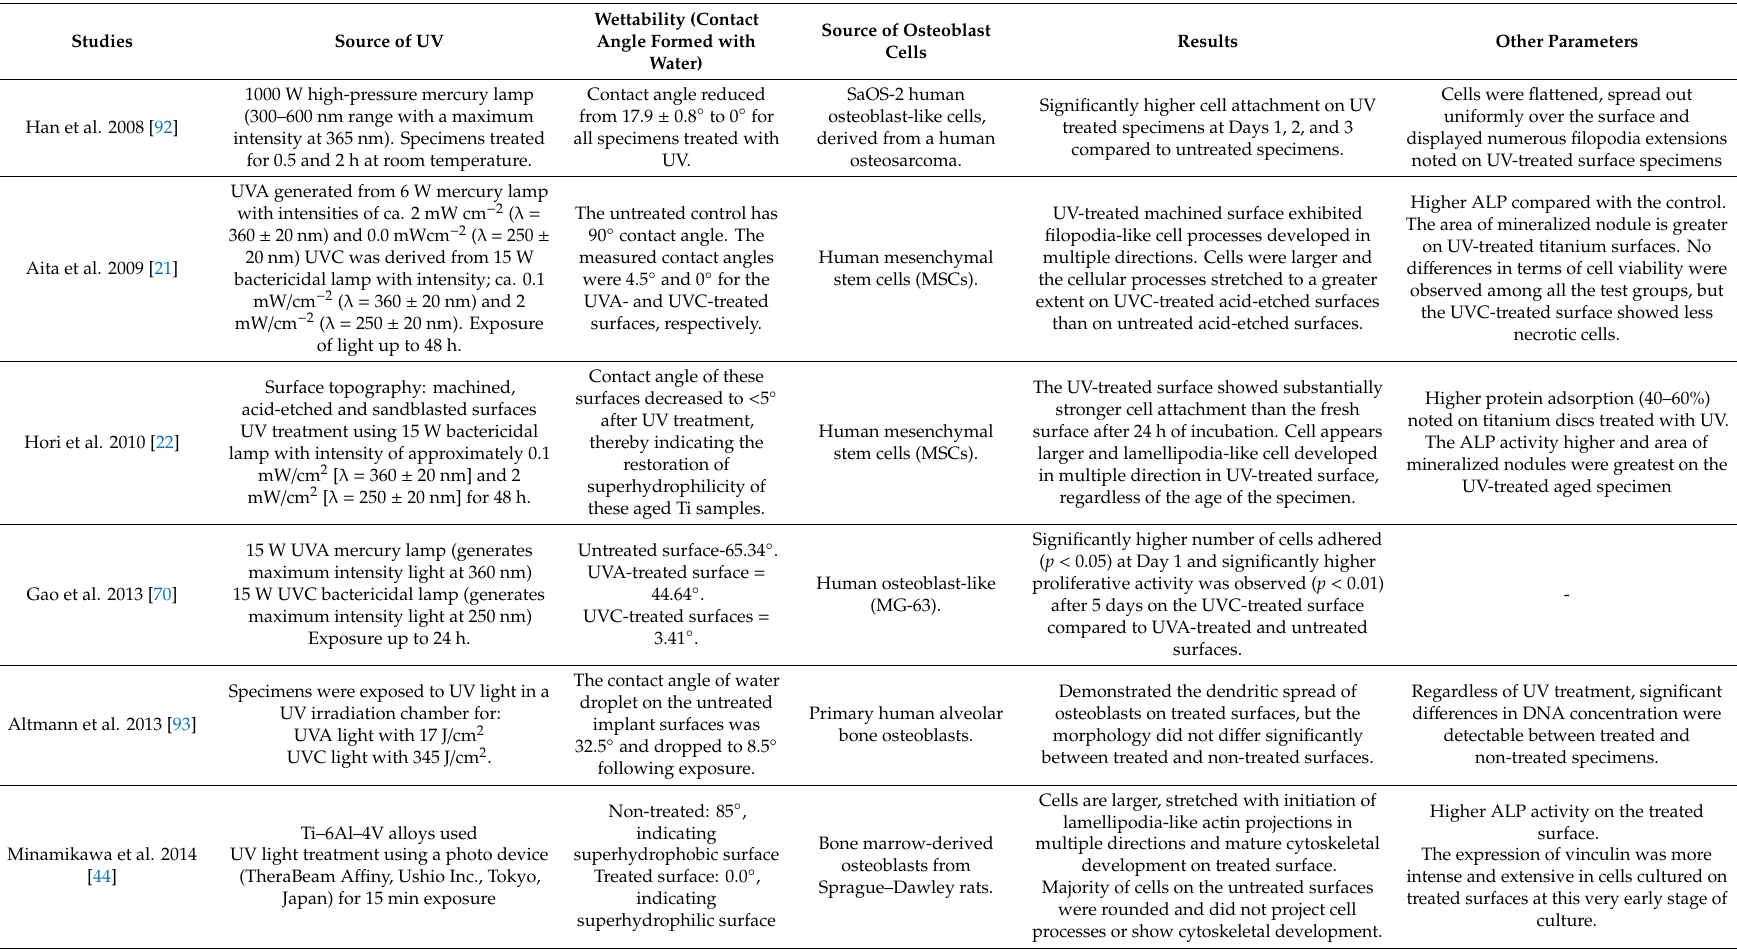
Table 2. Studies comparing the e ff ect of UV photofunctionalization of titanium surfaces on osteoblast cells of varying